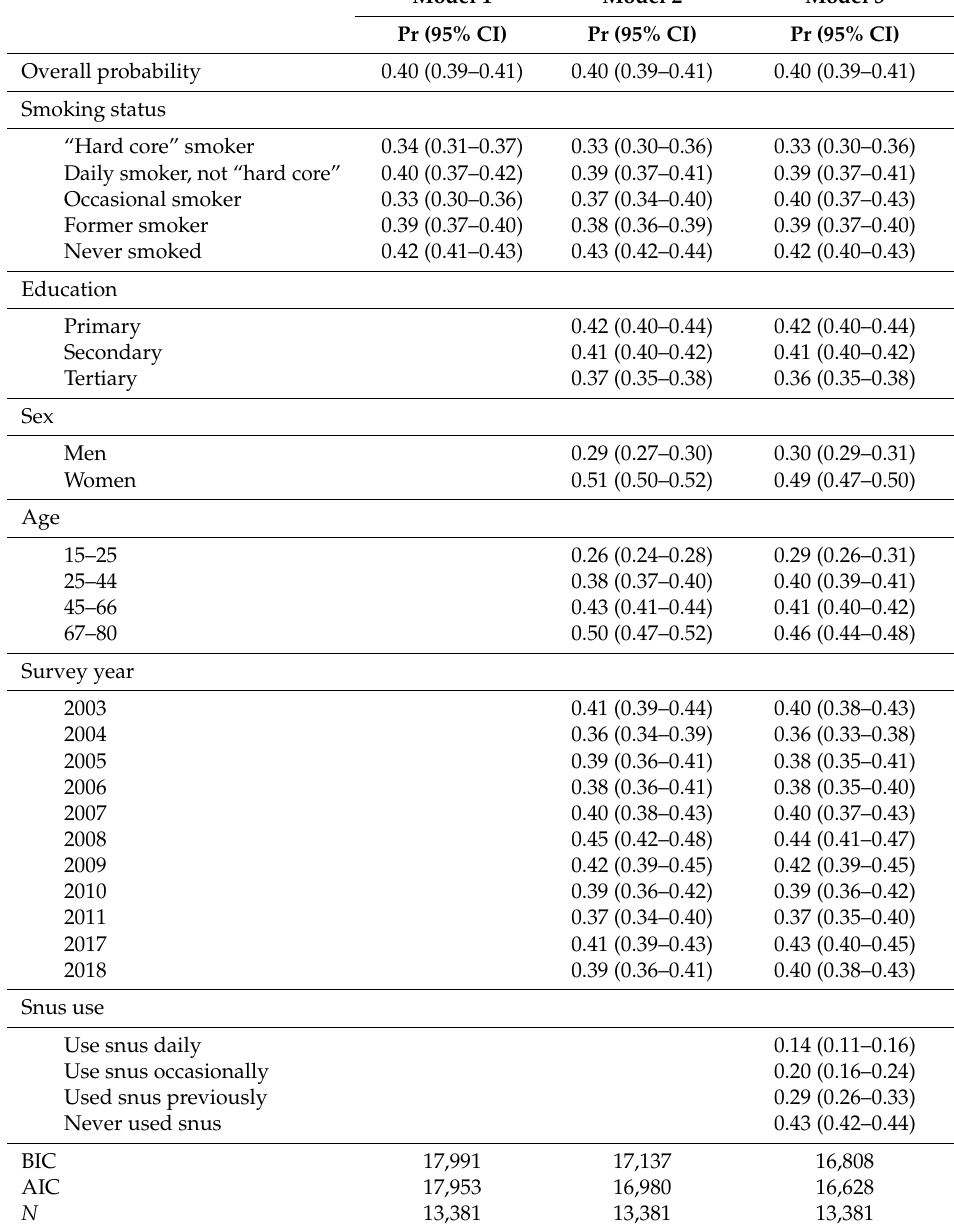
Table 2. Adjusted predicted probabilities (Pr) of perceiving snus as very harmful (score 6 or 7 on a scale from 1- slightly harmful to 7-very harmful) across tobacco use status, education, sex, age and survey